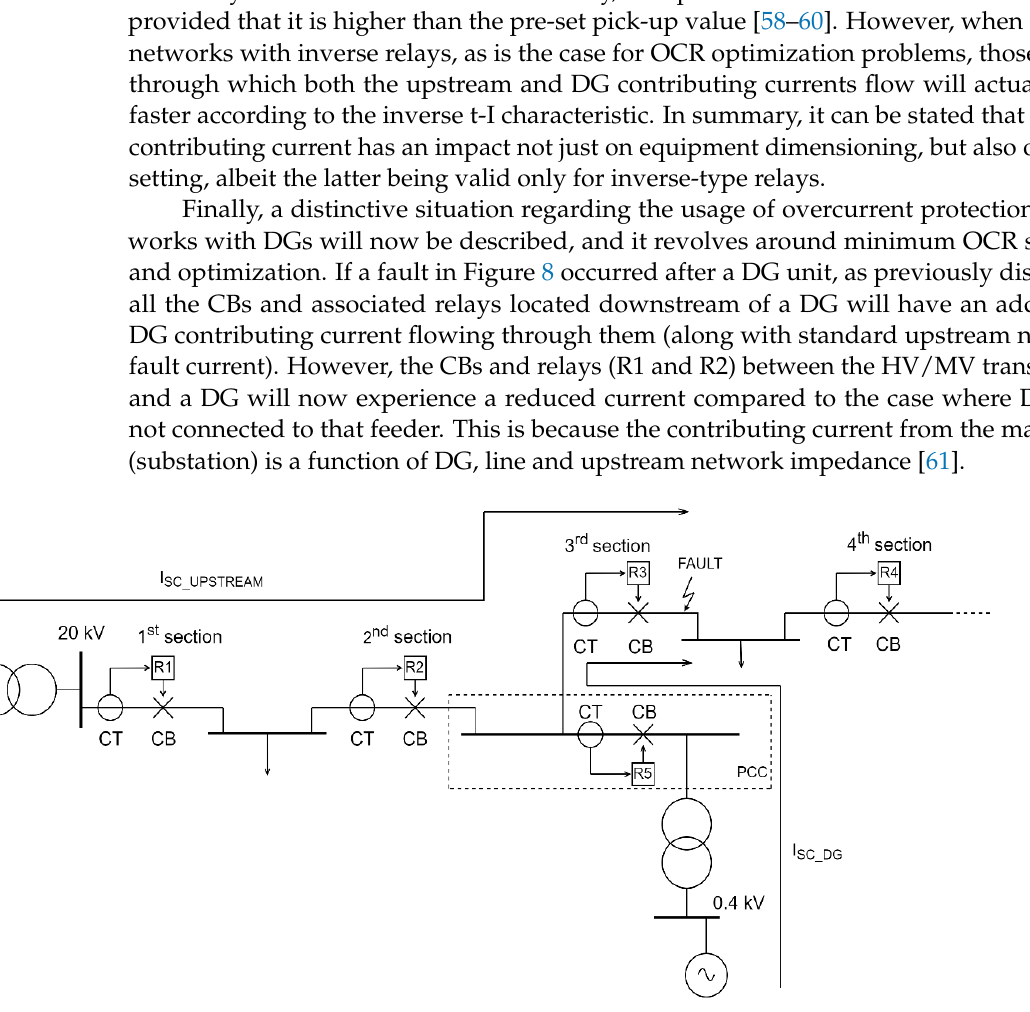
Figure 8. Possible “blinding” of upstream OCR protection for faults downstream of DG unit(s).